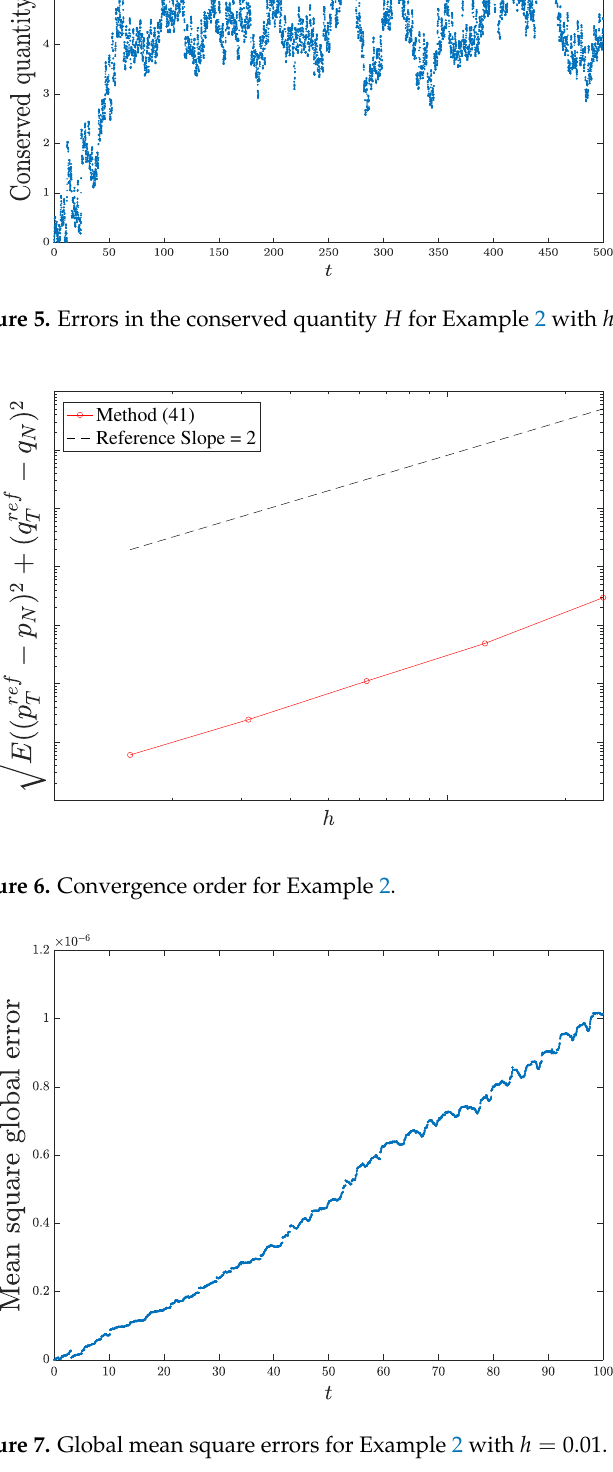
Figure 7. Global mean square errors for Example 2 with h =